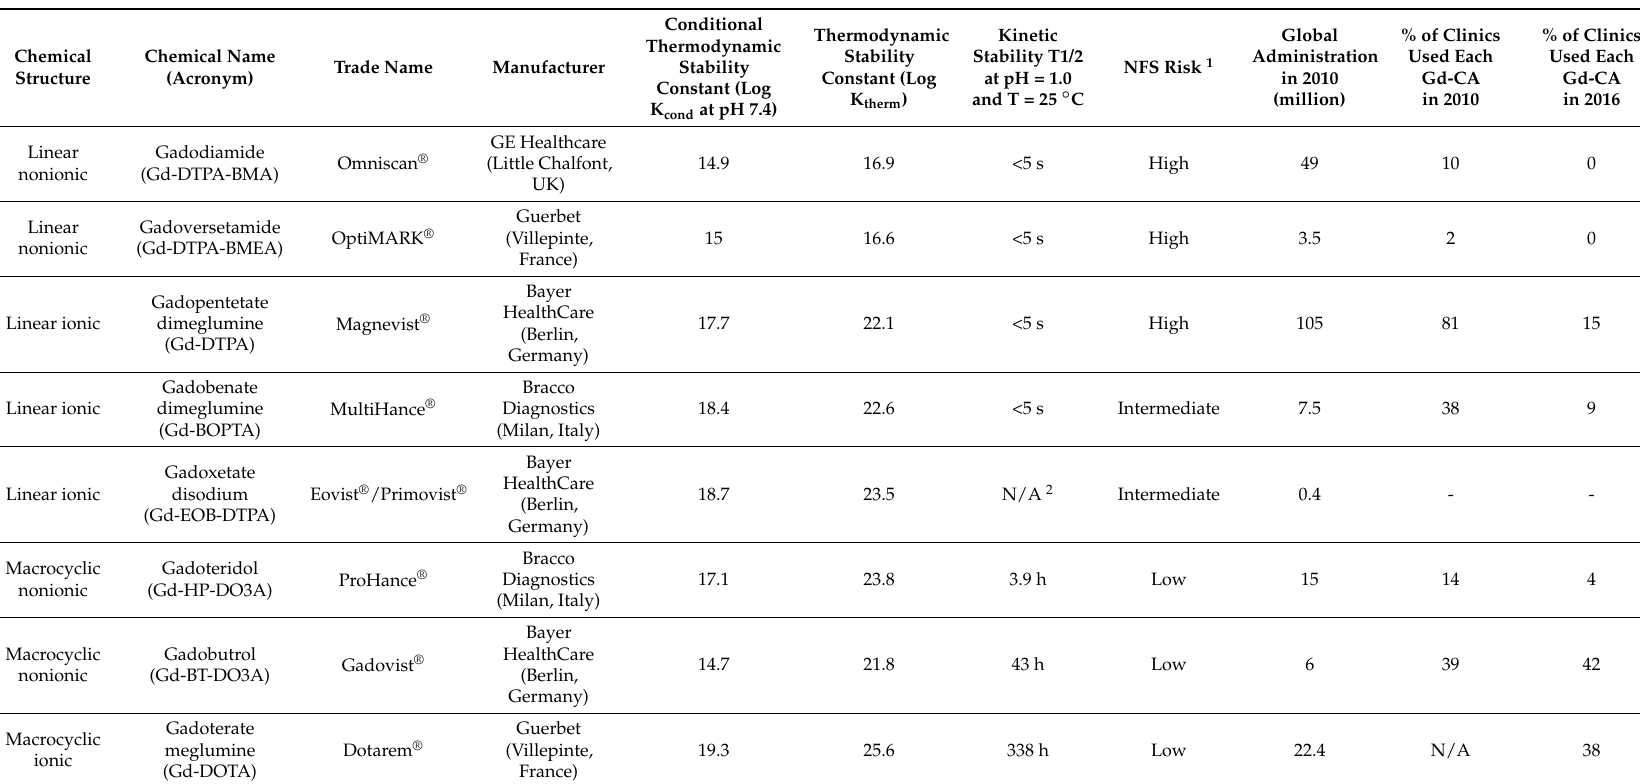
Table 3. Characteristics of currently marketed Gd-CAs approved by the U.S. Food and Drug Administration for body magnetic resonance imaging [101,103,105–110] and the proportion of pediatric radiology departments used Gd-CAs in 2010 and 2016 [111,112]. Dosage of all Gd-CAs is 0.1 mmol/kg, with the exception of gadoxetate disodium (0.025